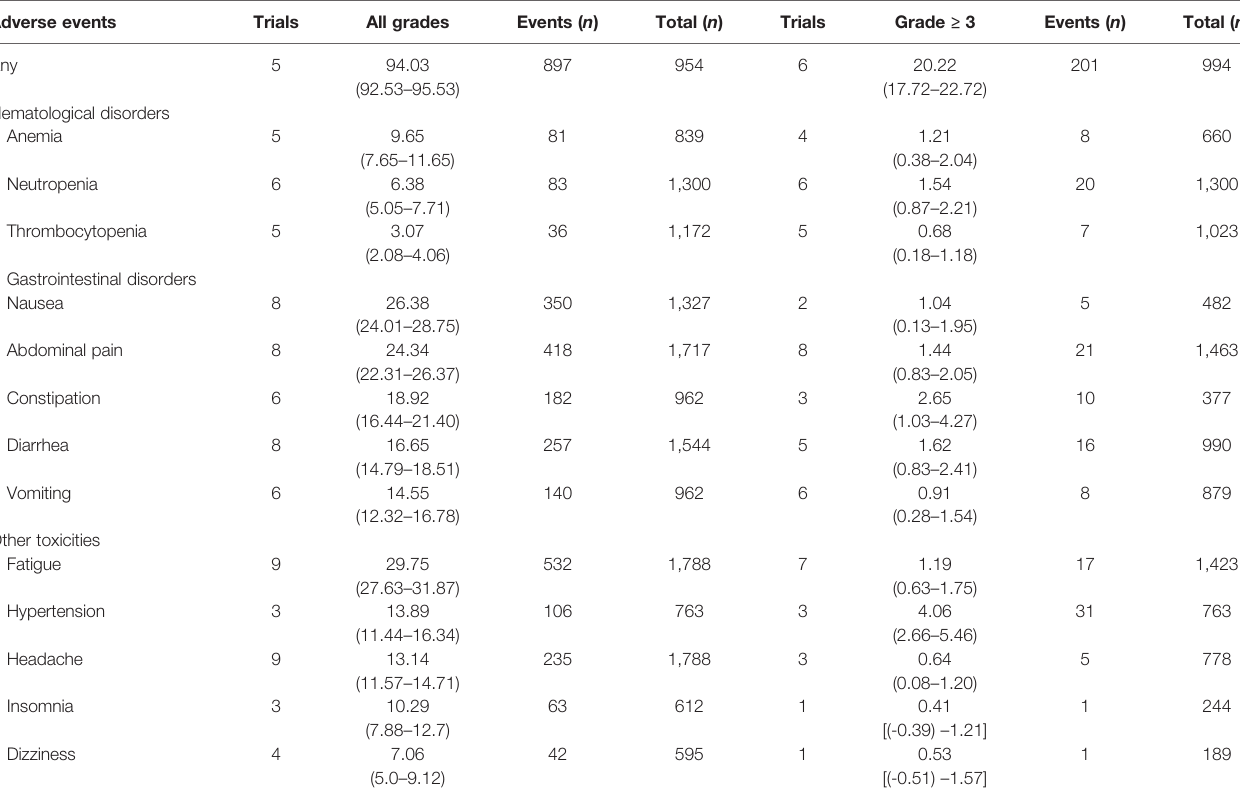
TABLE 2 | Overall incidences (%) and 95% con fi dence intervals of common adverse events in patients with placebo